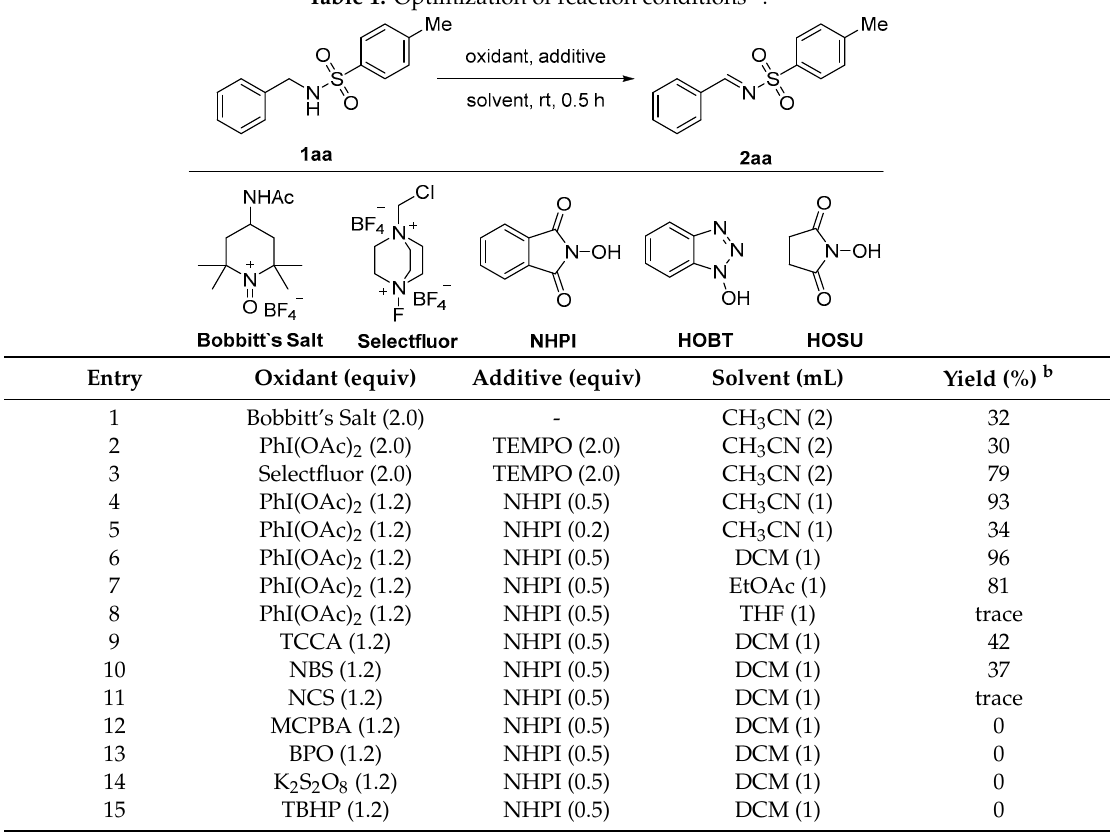
Table 1. Optimization of reaction conditions a .